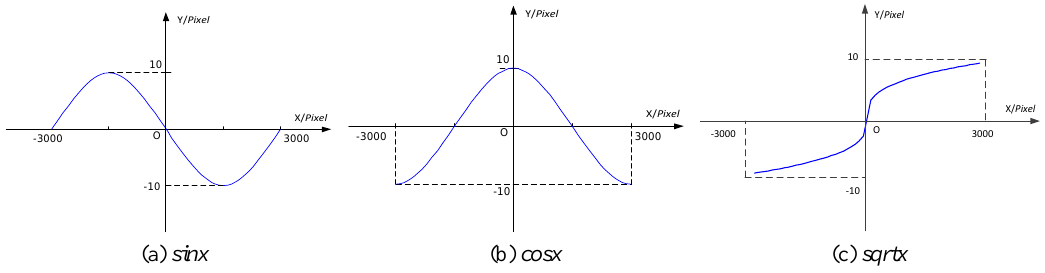
Figure 6. The designed internal distortions with different